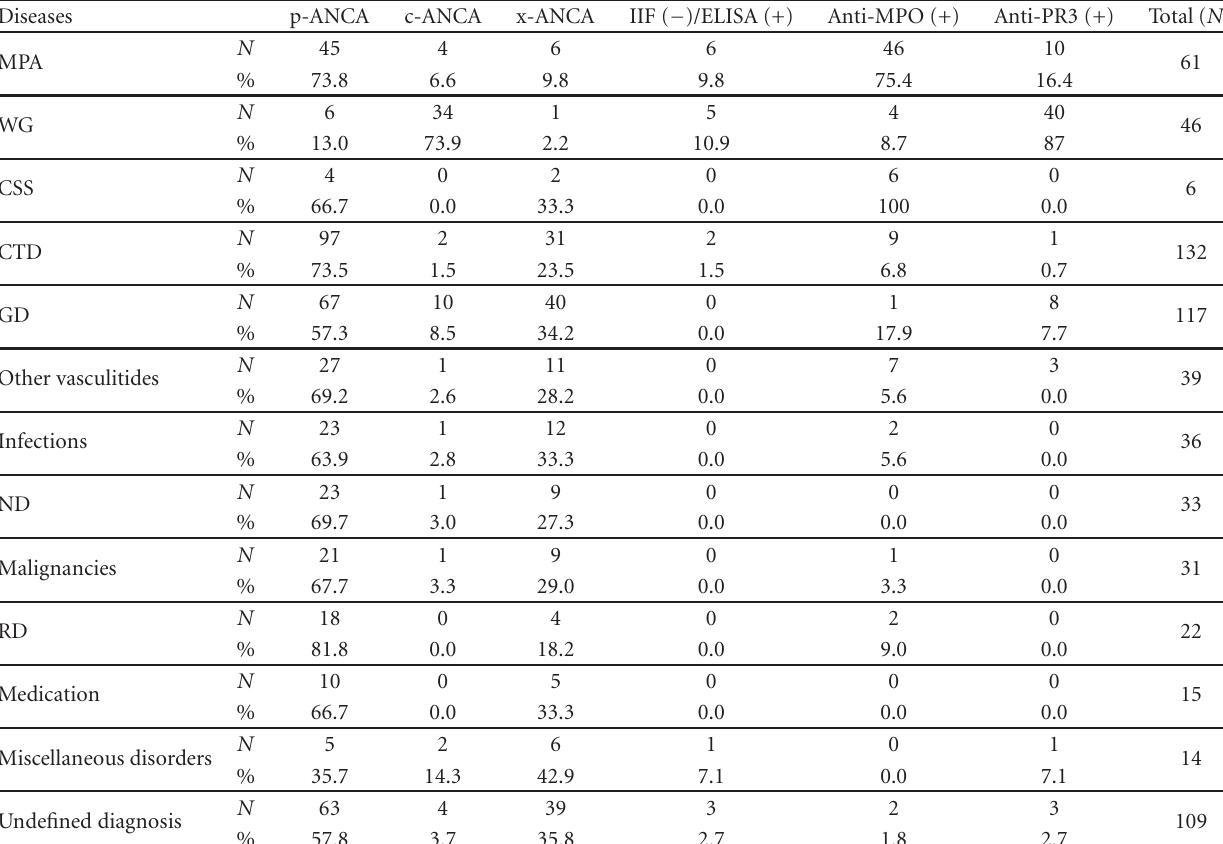
Table 3: Relationship between the results of ANCA testing and clinical diagnoses.